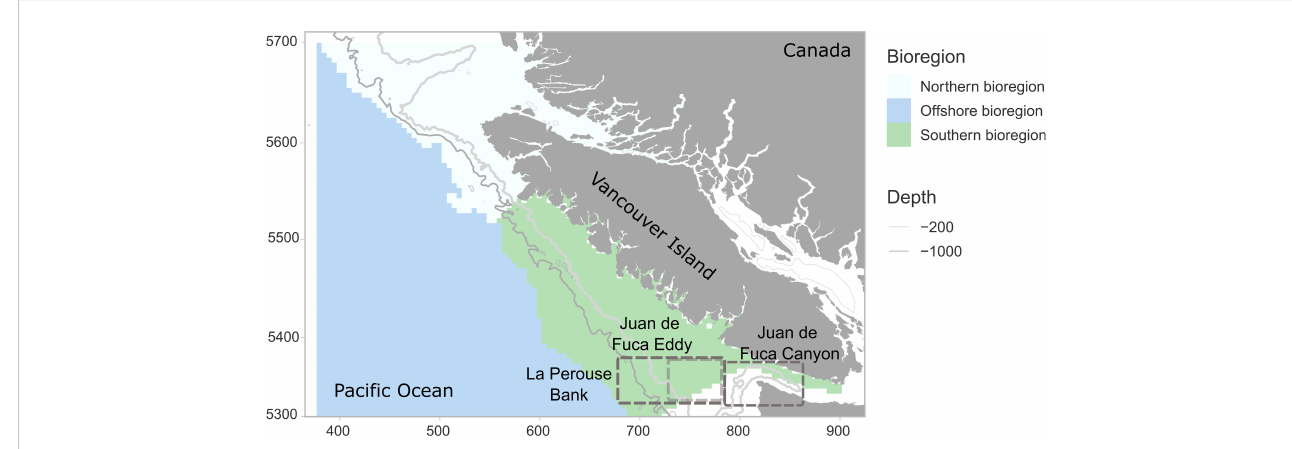
FIGURE 1 The study area showing boundaries for the southern, northern, and offshore bioregions. Depth contours are shown for 200m and 1000m, indicating the position of the continental shelf and slope and the Juan de Fuca canyon. The location of the La Perouse Bank, the Juan de Fuca Canyon, and the Juan de Fuca Eddy is indicated by grey boxes (the eddy position is shown by a lighter grey box). X and Y axis units are Universal Transverse Mercator in km (UTM - zone